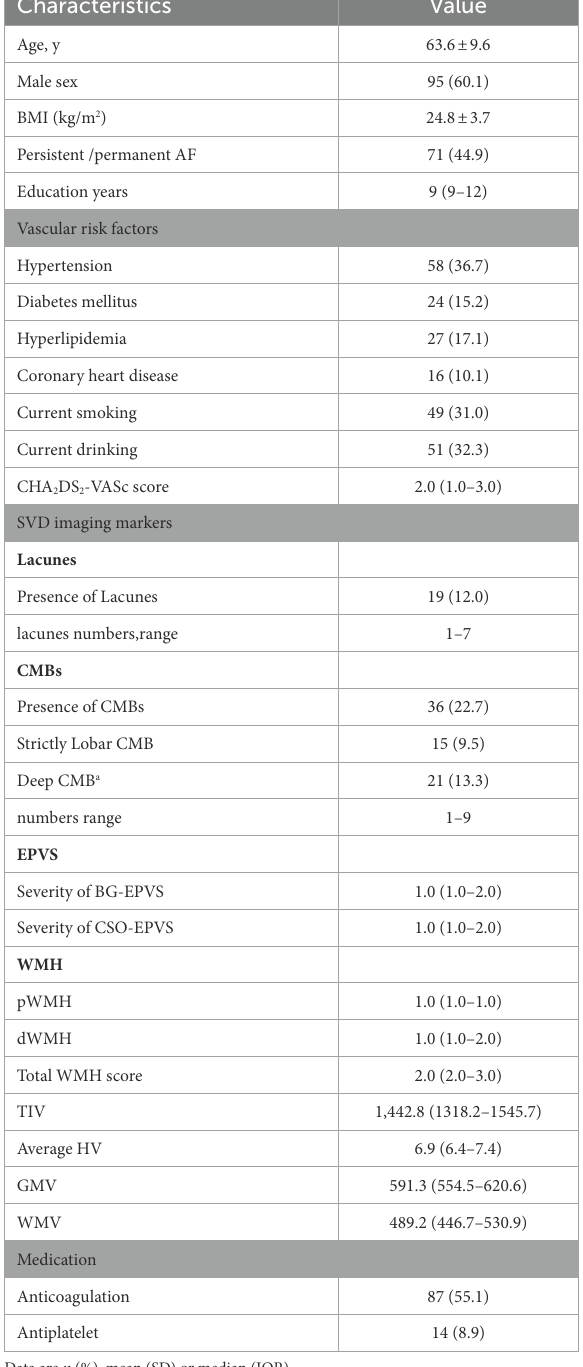
TABLE 1 Baseline characteristics of the study cohort ( n =